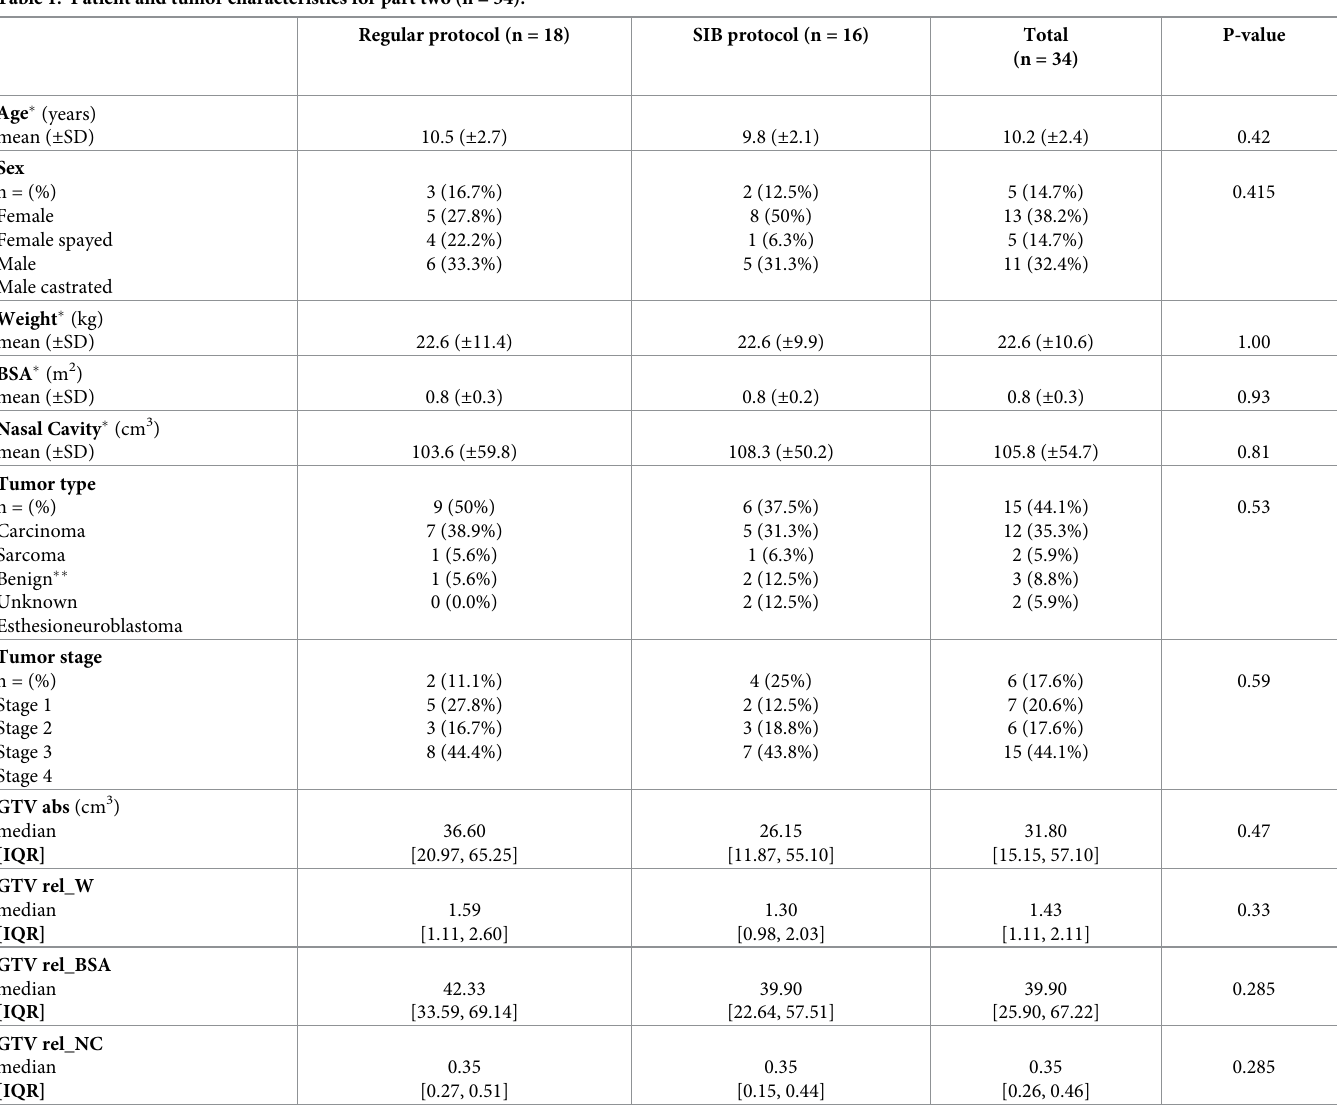
Table 1. Patient and tumor characteristics for part two (n =